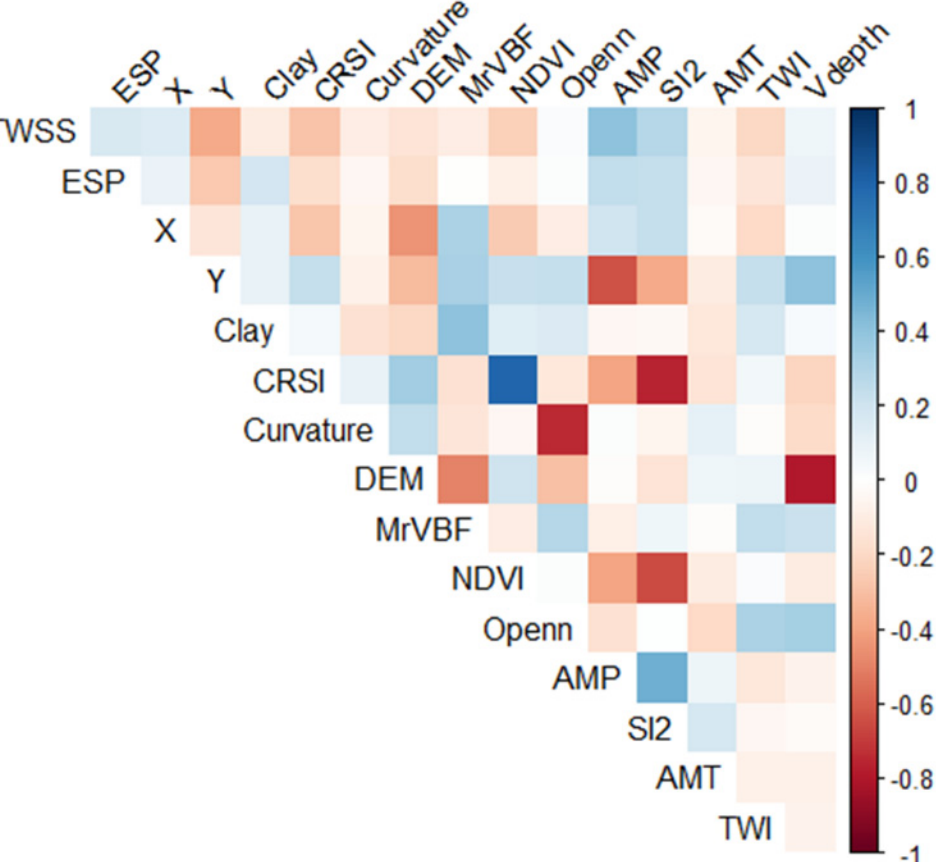
Figure 3. Correlation coefficients between the TWSS, exchangeable sodium percentage (ESP), and environmental covariates.